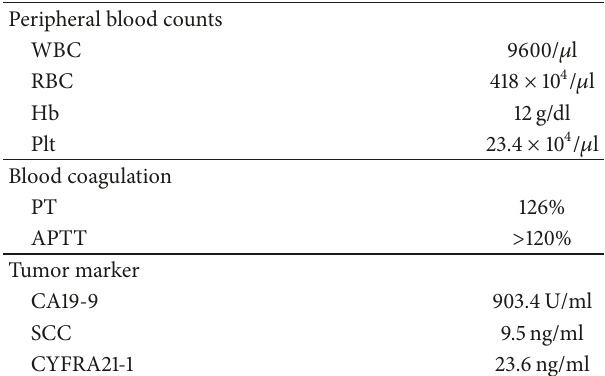
Table 1: Laboratory